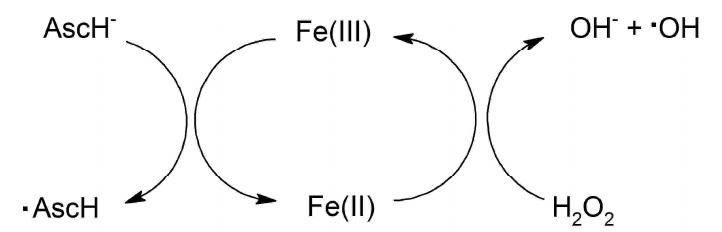
Figure 3. Ascorbate-driven cyclic Fenton reaction: schematic representation of the reduction of iron by ascorbate anion and the formation of the highly reactive hydroxyl radical ( • OH) in the presence of hydrogen peroxide (H 2 O 2 ).